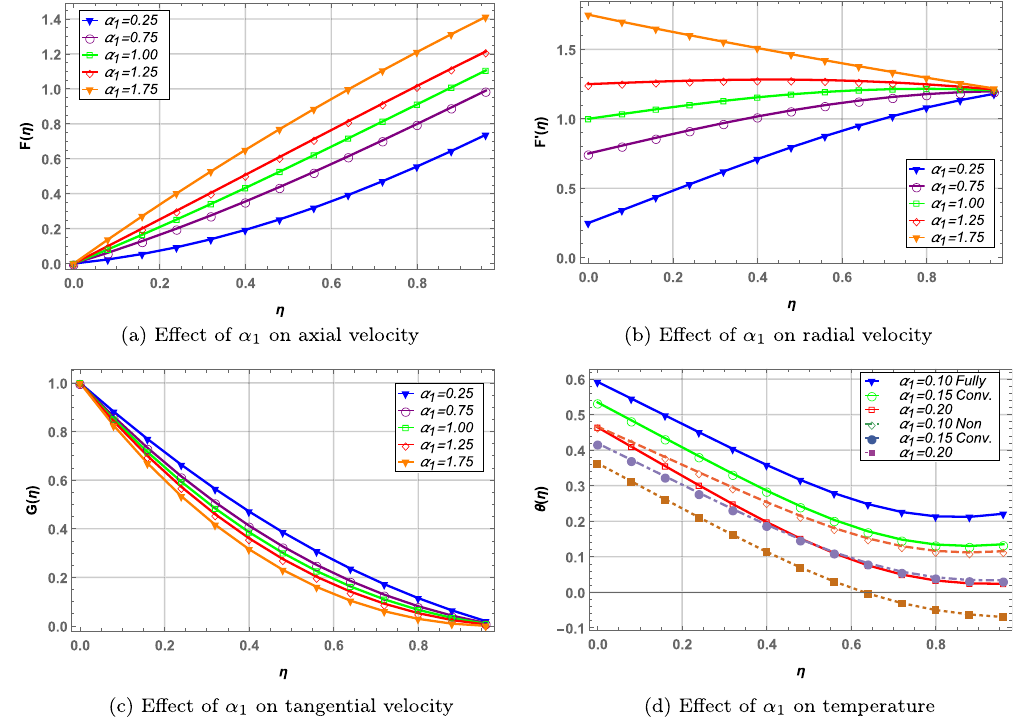
Figure 6. Effect of right disk stretching parameter on velocity and temperature profile.